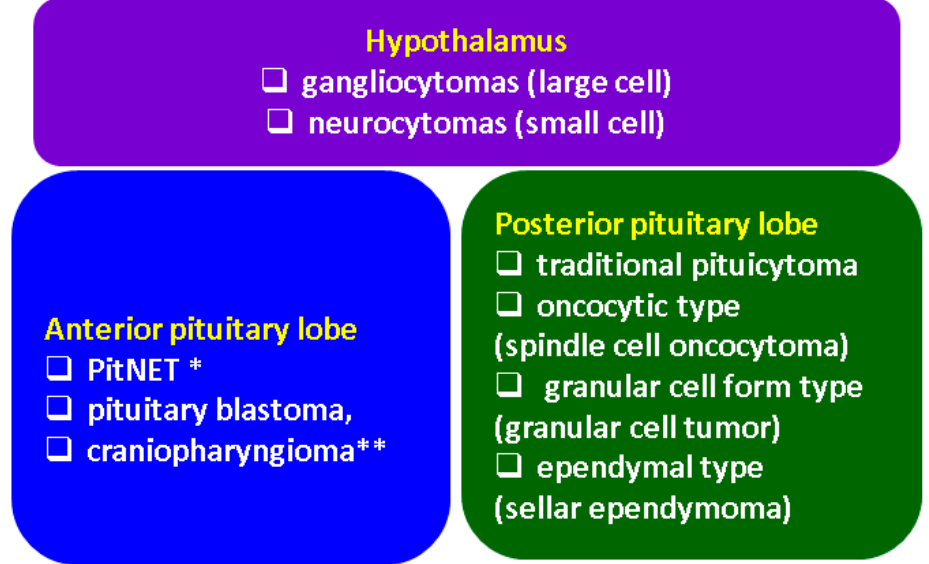
Figure 5. Integrating hypothalamic–pituitary tumors to new WHO 2022 criteria [223–226]. PitNET = pituitary neuroendocrine tumors; ∗ well-differentiated adenohypophyseal tumors (formerly pituitary adenomas); ∗∗ two specific subtypes.